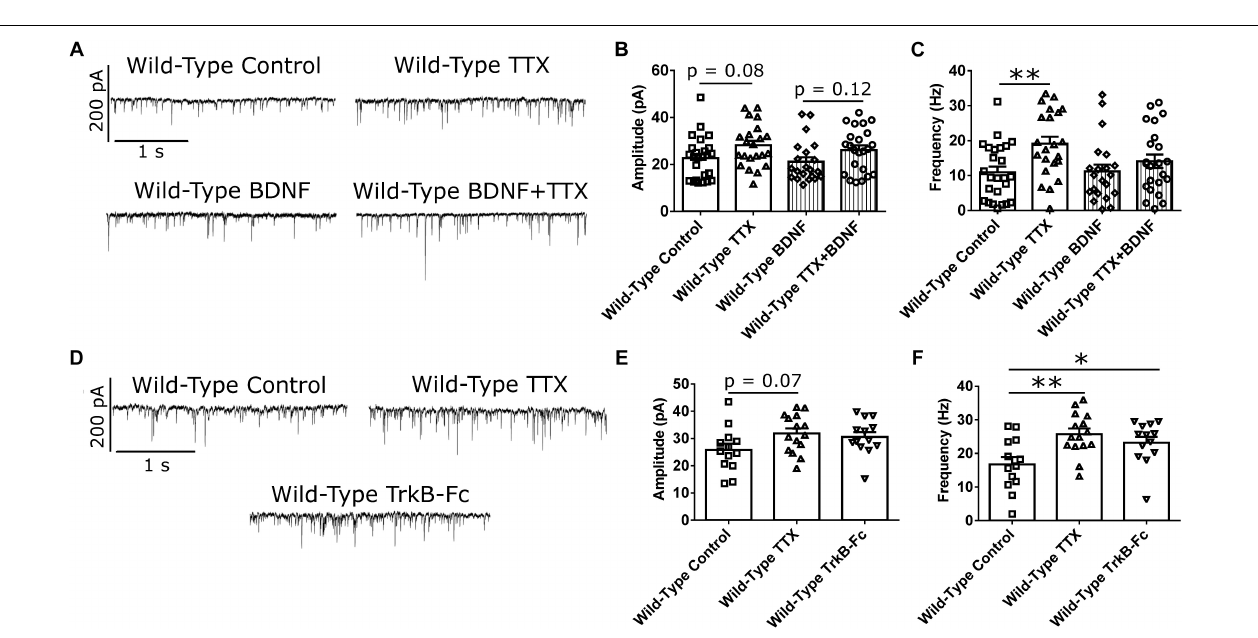
FIGURE 3 | BDNF signaling modulates mEPSC frequency in WT CPNs. (A) Representative traces of mEPSC recordings from WT CPNs treated with TTX and/or BDNF. (B) mEPSC amplitude of WT CPNs treated with TTX and/or BDNF. By two-way ANOVA, there was no significant post hoc difference between any groups, but there was a significant overall effect of TTX ( p < 0.01); moreover, TTX-treated cells tended to have larger mEPSCs in both vehicle control ( p = 0.08, Bonferroni post hoc t -test) and BDNF-treated ( p = 0.12, Bonferroni post hoc t -test) groups. (C) mEPSC frequency of WT CPNs treated with TTX and/or BDNF. Cells